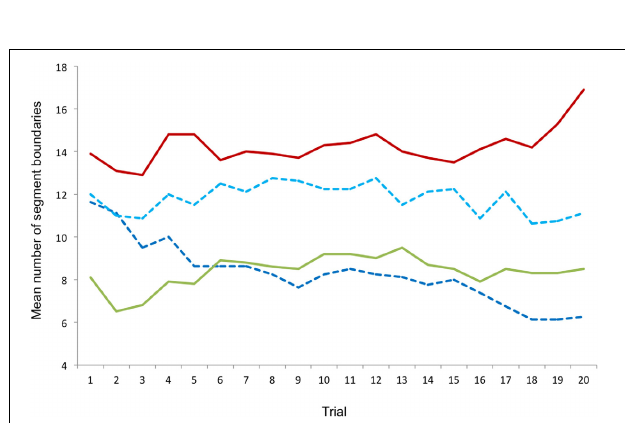
FIGURE 3 | Results of Experiment 1 (full lines) and Experiment 2 (dashed lines) combined, mean numbers of segment boundaries defined for individual trials. Red, non-dancers; green, dancers; light blue, amateurs before learning; dark blue, amateurs after